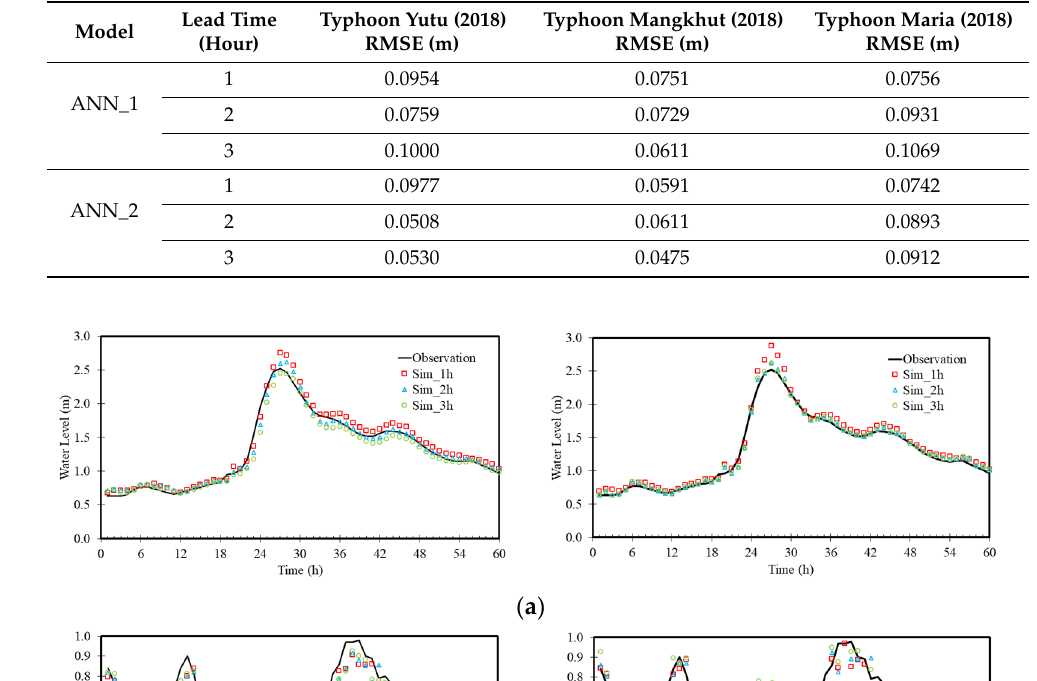
Table 6. Comparison of RMSEs for different ANN models and historical typhoon events.